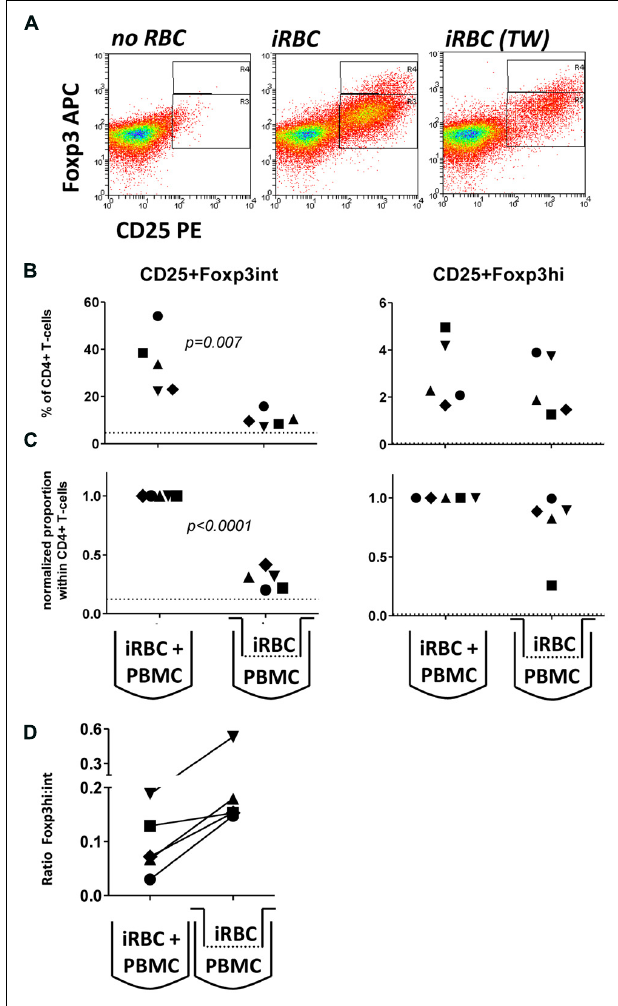
FIGURE 3 | Foxp3hi and to a lesser degree Foxp3int induction is mediated by soluble iRBC components smaller than 20 nm. To exclude large membrane fragments and intact hemozoin crystals and to examine the contribution of small soluble molecules derived from iRBCs to Foxp3 induction, intact iRBC were separated from PBMC through a transwell membrane (pore size 20 nm). (A) Representative dots plots for PBMCs from one donor cultured in direct contact with iRBCs compared to transwell-separated iRBCs. (B) Proportions of Foxp3hi and Foxp3int CD4 + CD25 + T cells were determined on day 6 as a percentage of CD4 + T cells for five donors in two independent experiments. (C) Values of all conditions were normalized for proportions induced by direct co-culture with iRBCs for each donor.Vertical bars represent median values. (D) The ratio of Foxp3hi:Foxp3int cells within the CD4 + CD25 + T cell population was calculated for each individual donor in direct or transwell separated co-cultures.Vertical bars represent median values. Individual donors are identified by unique symbols. Dotted lines show the upper 95% confidence interval of the mean of uRBC-stimulated control